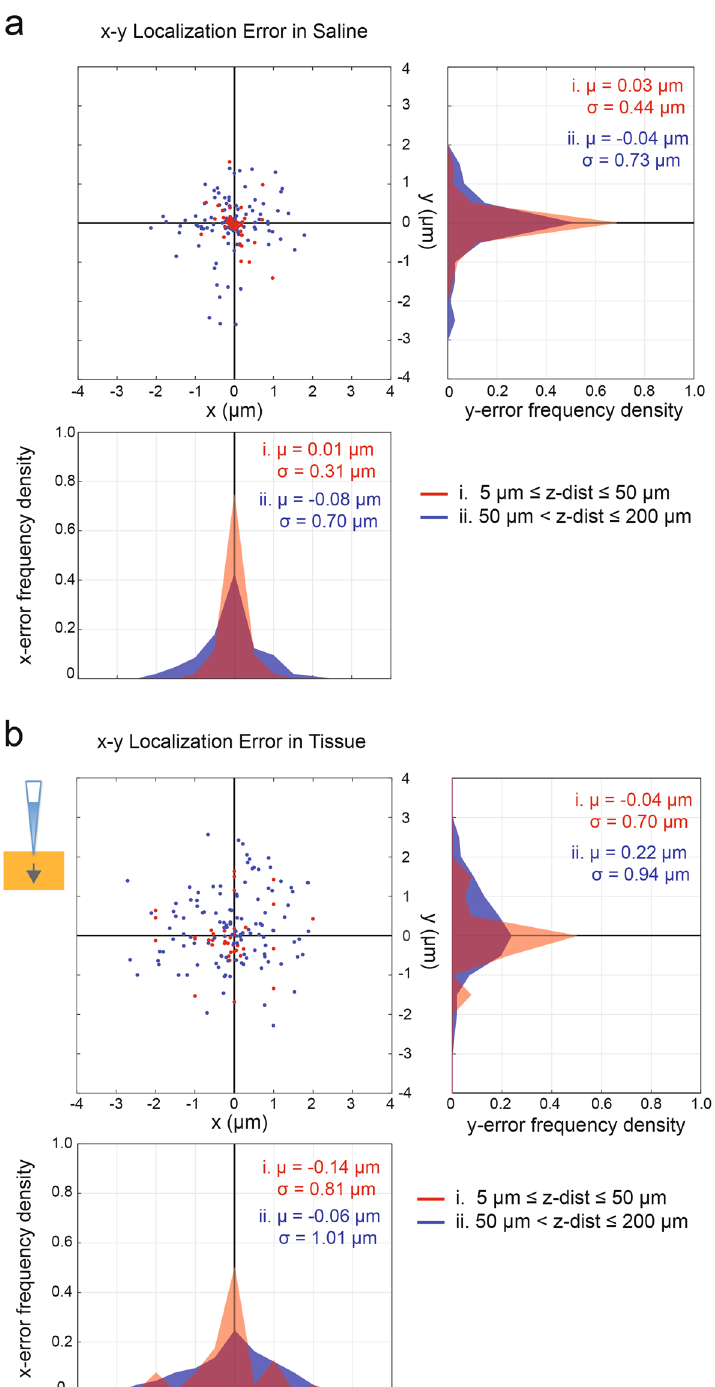
Figure 2. HD-MEA electrical imaging enables x-y localization of a point source in saline and in acute brain slices. The x-y errors of localization experiments for a point source in saline are shown in ( a ). The top left panel shows the x-y errors, when the pipette z distance was (i) 5 μ m ≤ z-distance ≤ 50 μ m (red dots, N = 51) and (ii) 50 μ m < z-distance ≤ 200 μ m (blue dots, N = 106). Each dot refers to the difference between measured against estimated x-y location of the pipette. The frequency density histograms of the x-errors (bottom panel) and y-errors (right panel) are shown. The histograms display the number of times a localization estimate yields a certain error value within a bin-width of 0.5 μ m for a range of − 4 to 4 μ m. This error value was normalized with respect to the total number of trials in a specified experimental condition (e.g., saline (i) has 51 trials). ( b ) x-y error results as in a, but obtained from experiments with acute brain slices, where (i) N = 40 and (ii) N = 118. The arrow in the small schematics indicates the pipette movement into the tissue. The x-y errors in b are based on measured x-y locations determined by the manipulator movement and by using calibration